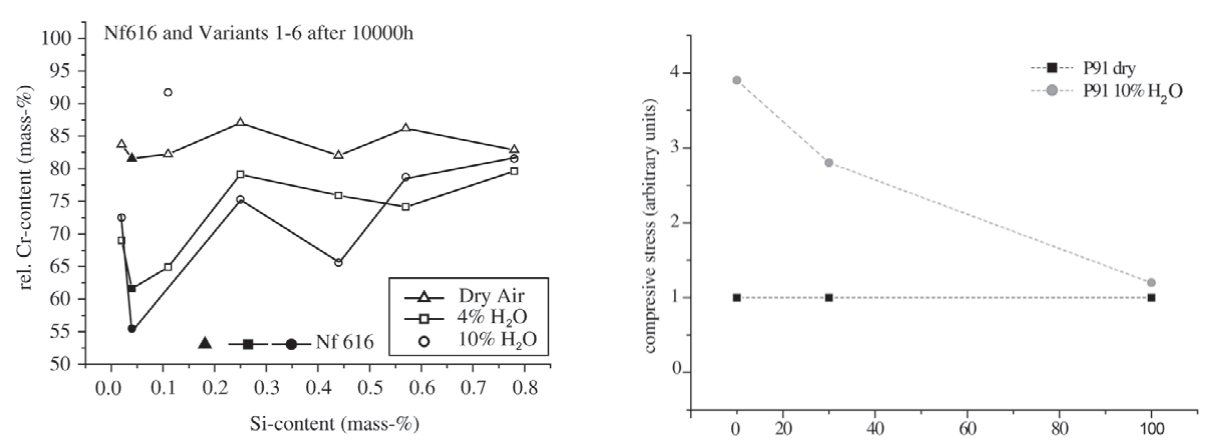
Figure 15. Relative amount of Cr underneath the oxide scale as a function of the silicon content after 10000 h for 6 laboratory ver- sions and the pre-commercial version of Nf616 at 650 °C in differ- ent environments (100% = 9% Cr).